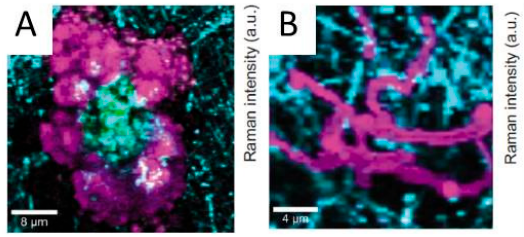
Figure 15. Formation of ring like ( A ) and filament-like corrosion products, characteristic of filiform corrosion ( B ). Reproduced from reference [106] by permission of The electrochemical Society. Copyright 2010.